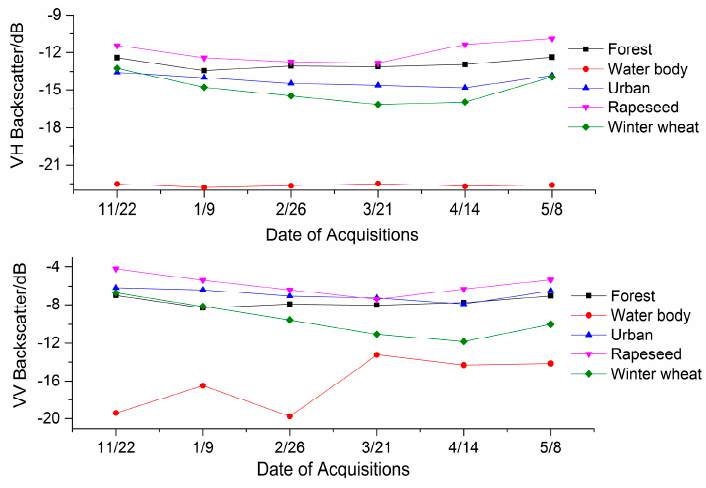
Figure 2. Average backscatter values for each land cover class on six image acquisition dates.